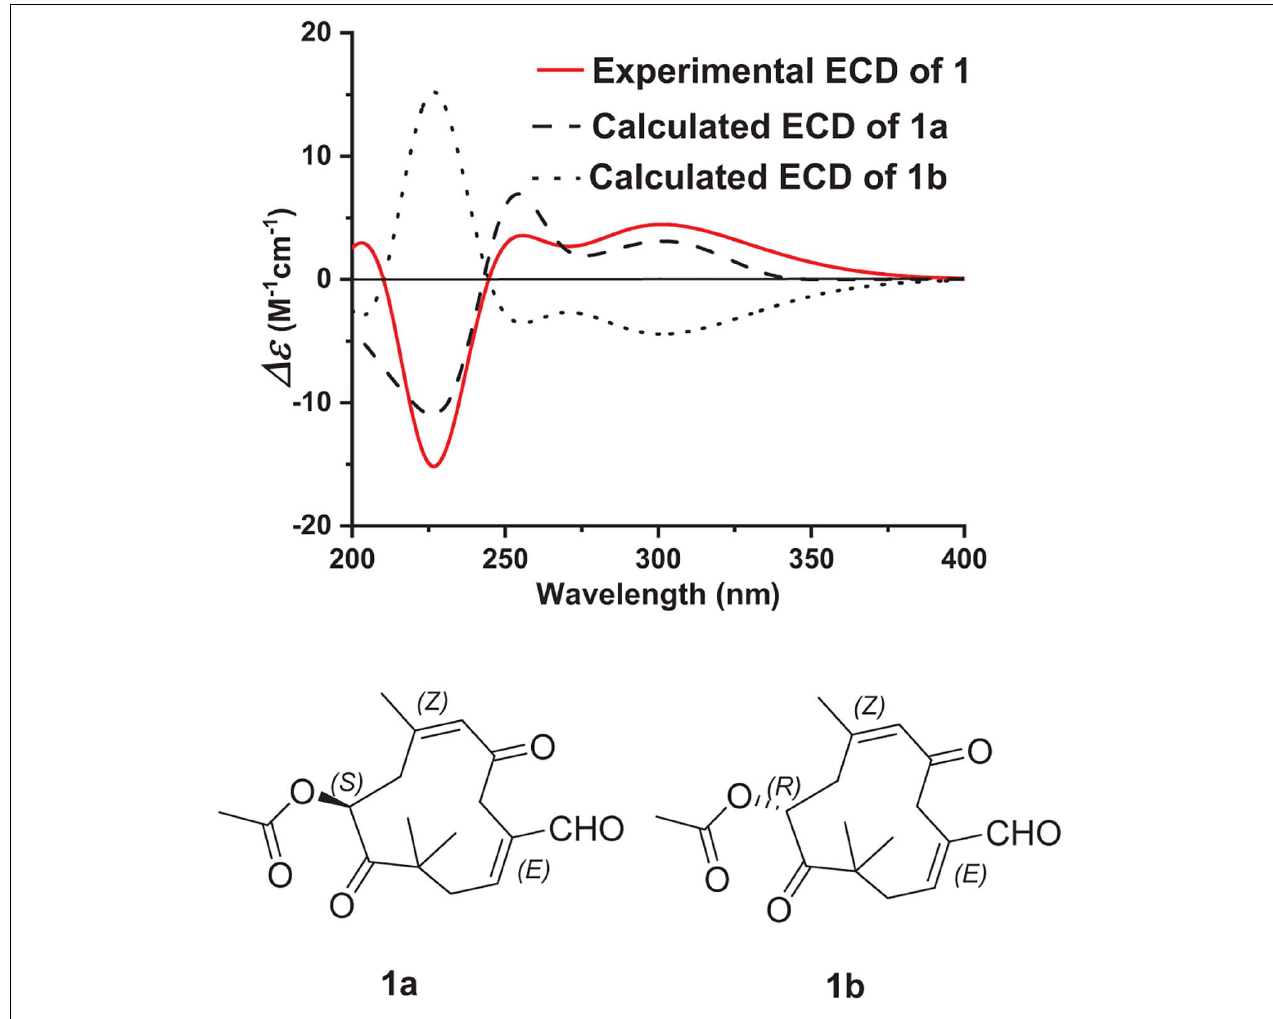
FIGURE 4 | Experimental ECD spectrum of 1 in MeOH and the calculated ECD spectra of 1a and 1b .